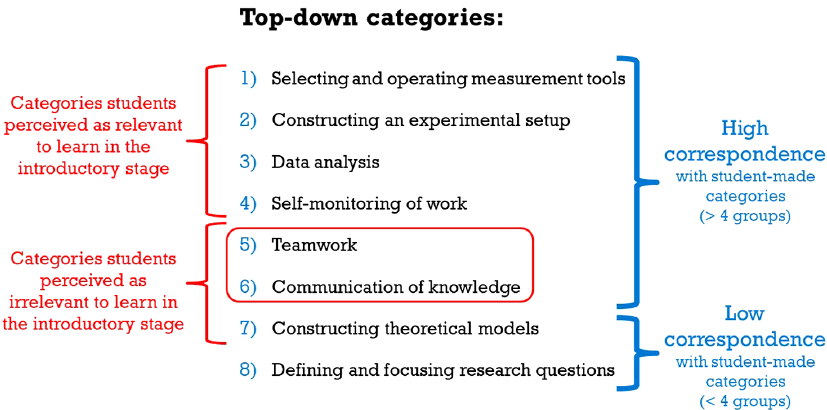
FIG. 2. Overview offindings: correspondence between student-made and top-down categories and perceived relevance of each